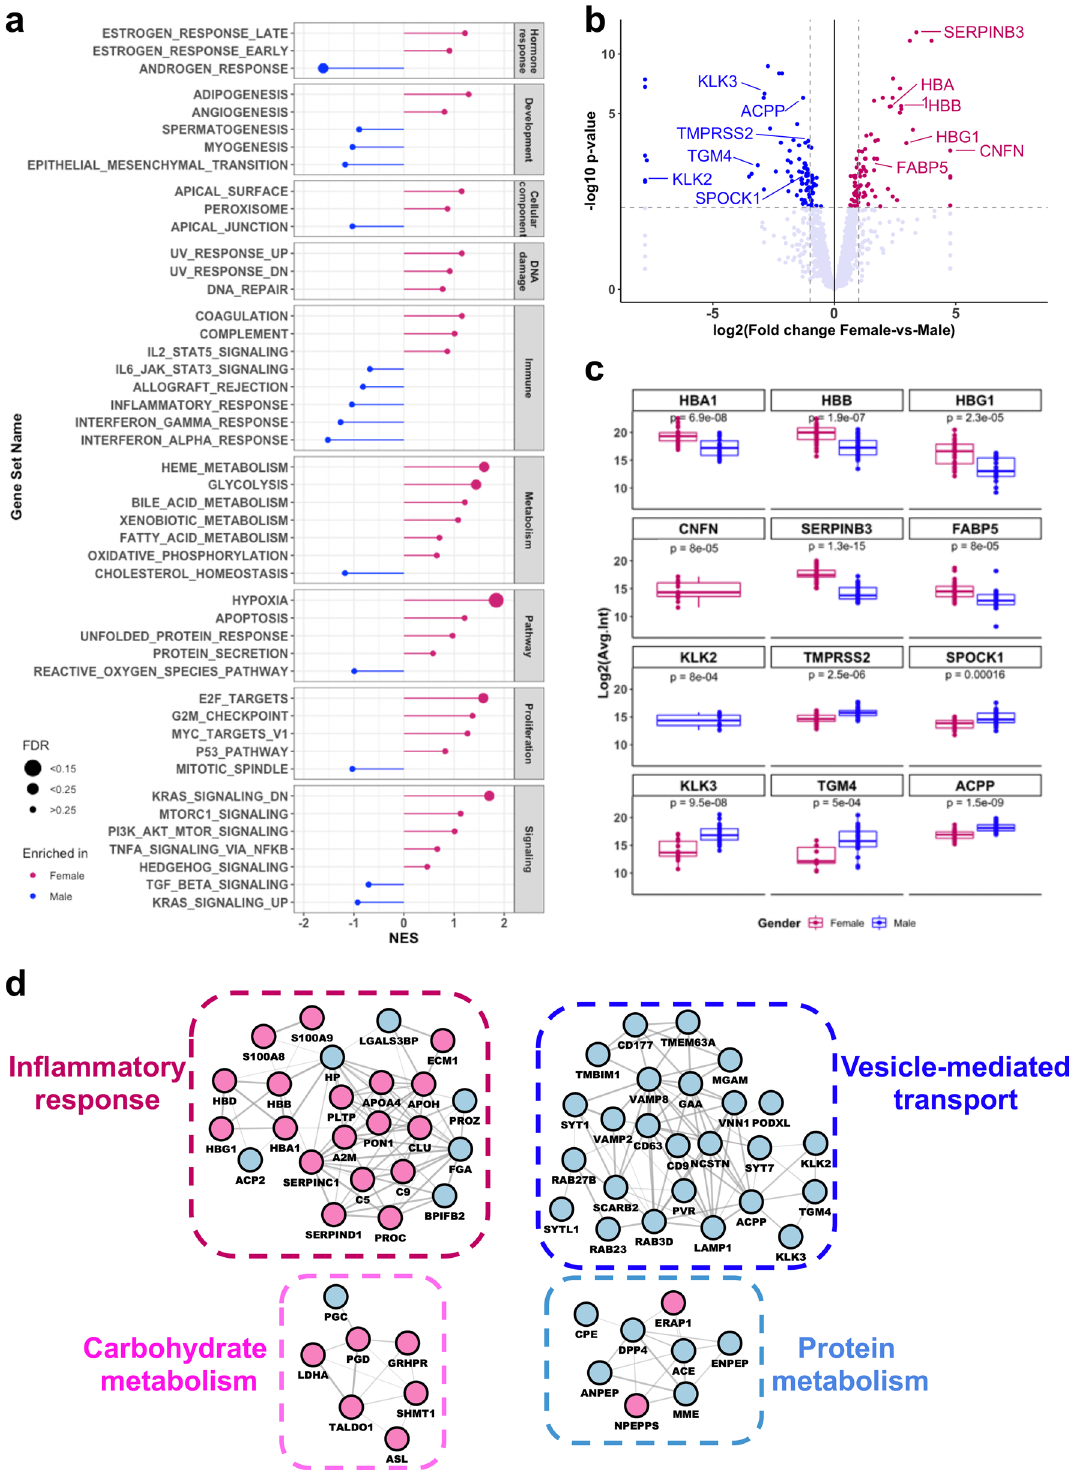
Figure 4. Gender-based differences in the urinary EV proteome. ( a ) Gene set enrichment analysis (GSEA, hallmarks) of the differential analysis between female- and male-derived urinary EVs was performed by ranking proteins based on the sign of their fold change and p-value, with proteins significantly overexpressed in females at the top of the list. Gene sets enriched in females are marked pink, and gene sets enriched in males are marked blue. The size of the dot reflects the significance of the enrichment (false discovery rate). ( b ) Volcano plot of the urinary EV protein expression levels between female and male samples. Colored dots indicate the 172 proteins that were significantly different between female or male samples. A total of 89 proteins were upregulated in males (left side, in blue), whereas 83 proteins were overexpressed in females (right side, pink). Proteins-of-interest that are shown in Fig. 4C are annotated in the plot. ( c ) Expression levels of selected female- (upper 2 panels) and male-specific (lower 2 panels) urinary EV proteins, showing an enrichment of gender-specific proteins in the expected samples. ( d ) Protein interaction networks enriched in female (left) and male (right) urinary EVs, predicted by clusterONE 31